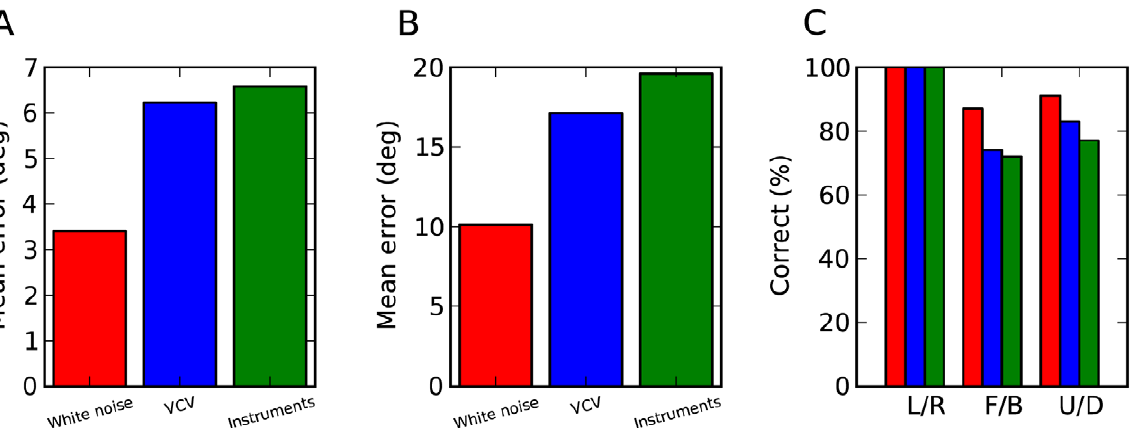
Figure 13. Performance of the model in low frequencies (under 3kHz). (A, B, C) Performance of the approximate model, as in Fig. 5G–I, for low frequencies only (80 channels distributed on the ERB scale from 150Hz to